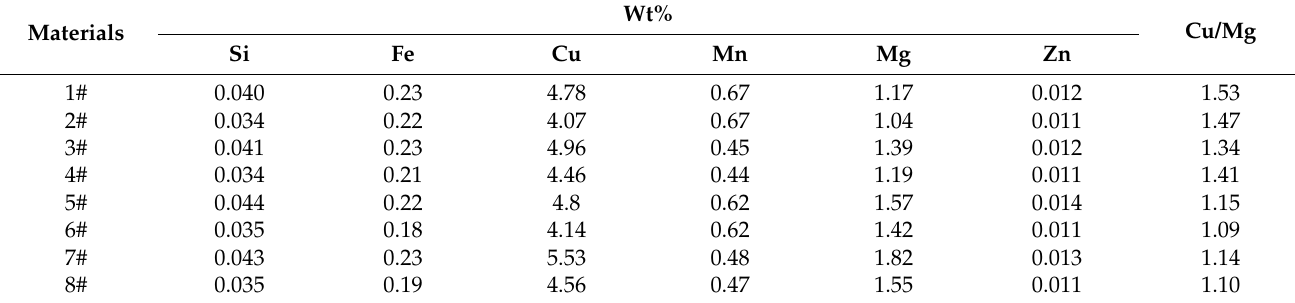
Table 1. The compositions of 2024 T3 plates with different contents of Cu and Mg.